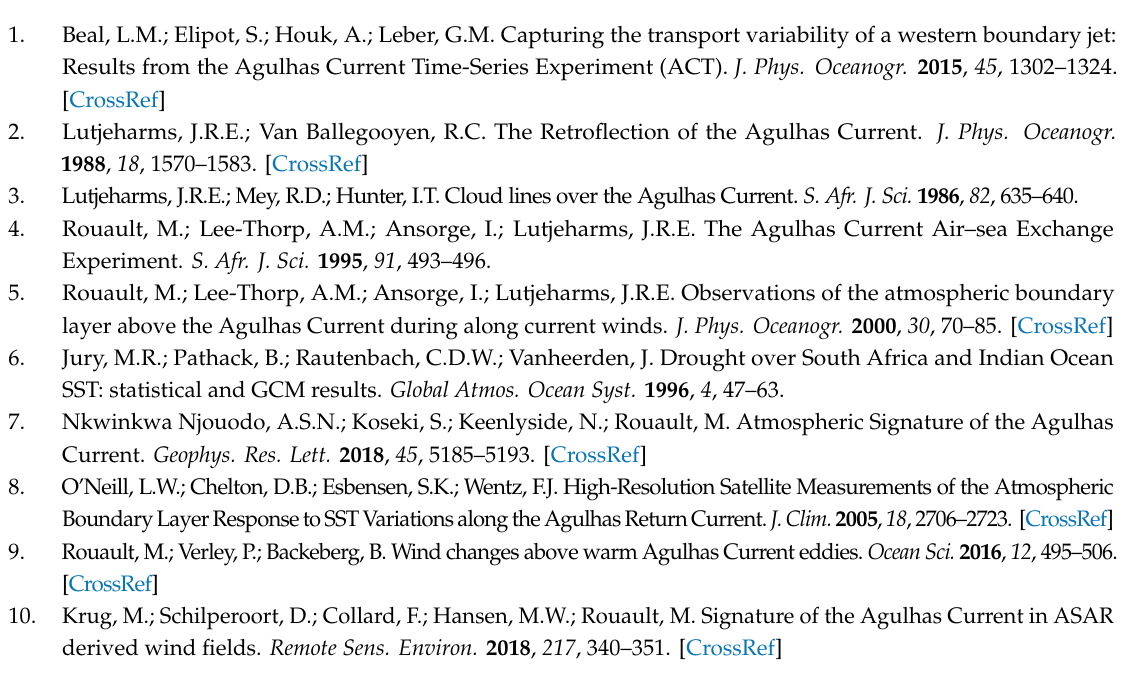
Figure S1: Mean seasonal di ff erences of wind speed (m / s) between Equivalent Neutral wind speed and real wind speed calculated using the BVW height adjustment code, for CFSR, MERRA2, ERA-Interim and NOCS products. From left to right Austral summer (DJF), austral autumn (MAM), austral winter (JJA) and austral spring (SON). Equivalent Neutral wind speed is between 0.1 and 0.5 m / s more than the recalculated real wind speed. Figure S2: Mean seasonal di ff erences of Qa (g / kg) between Qa at 2 m and Qa at 10 m calculated using the BVW height adjustment code for CFSR and ERA-Interim product. From left to right Austral summer (DJF), austral autumn (MAM), austral winter (JJA) and austral spring (SON). Qa at 2 m is between 0.3 and 0.8 more than the recalculated Qa at 10 m. Figure S3: SEAFLUX 5-day average climatology of latent heat flux (blue) and wind speed (wind speed) from 2003 to 2007, o ff Durban, o ff Port Elizabeth, Retroflection region, and o ff Cape Town, with their respective